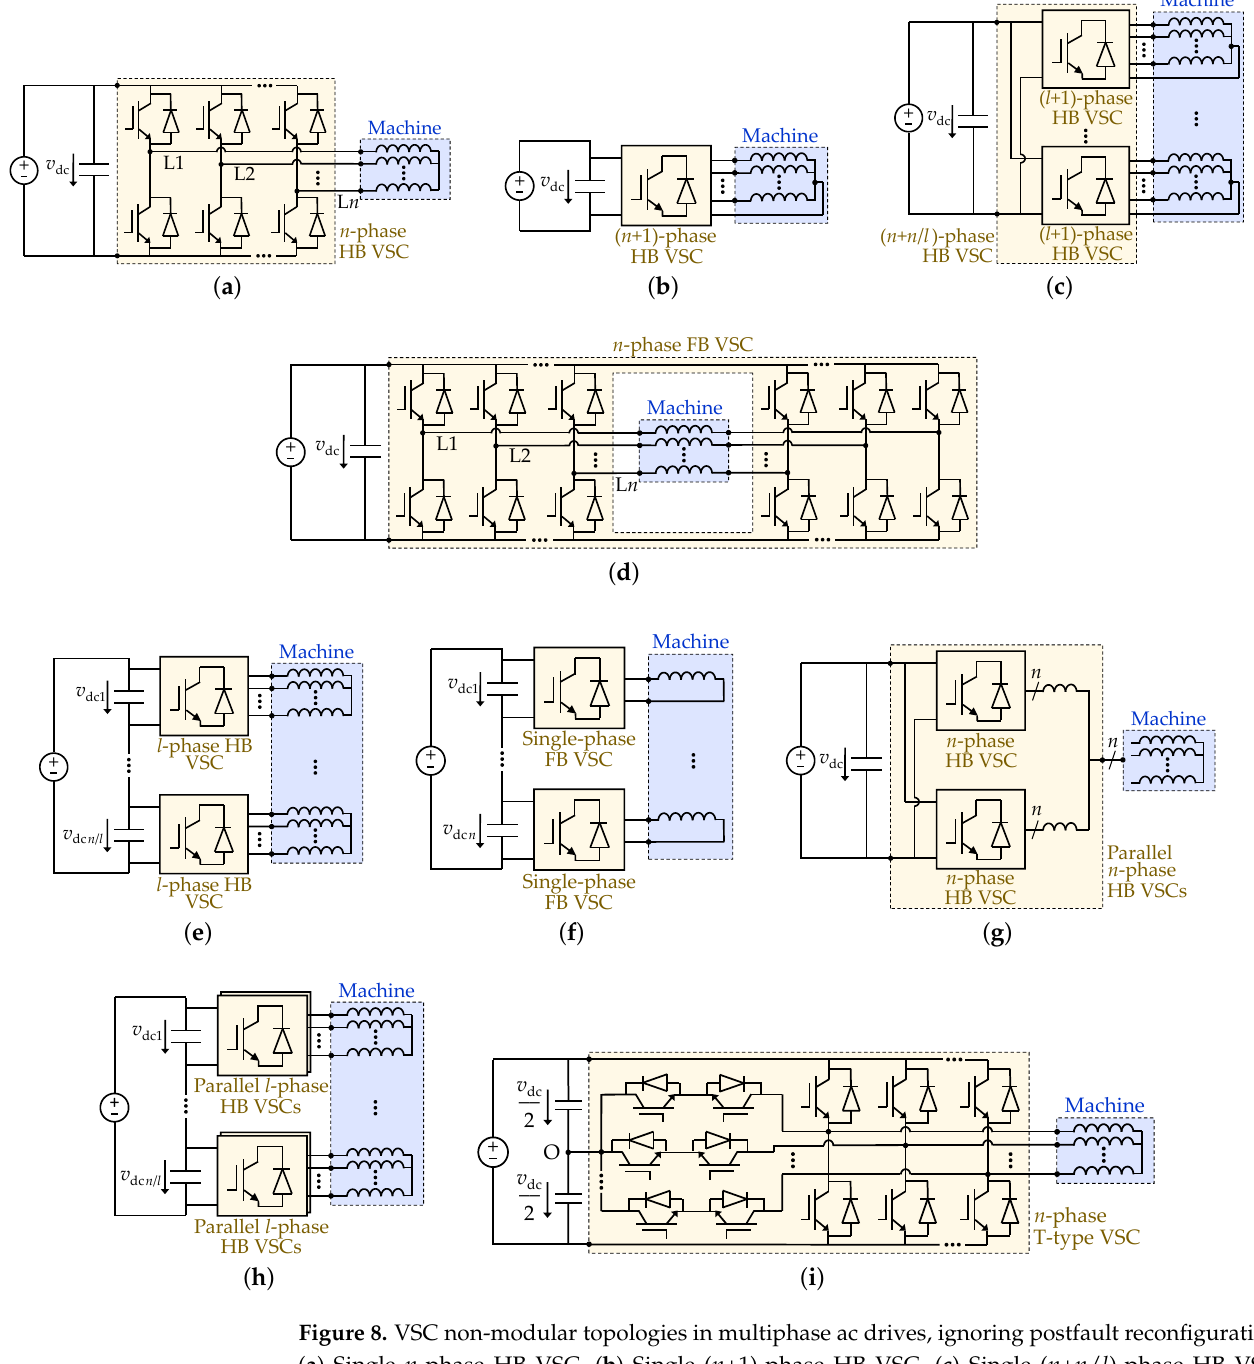
Figure 8. VSC non-modular topologies in multiphase ac drives, ignoring postfault reconfiguration. ( a ) Single n -phase HB VSC. ( b ) Single ( n +1)-phase HB VSC. ( c ) Single ( n + n / l )-phase HB VSC. ( d ) Single n -phase FB VSC for open-end windings. ( e ) Series dc-side connection of l -phase HB VSCs. ( f ) Series dc-side connection of single-phase FB VSCs. ( g ) Parallel n -phase HB VSCs. ( h ) Series dc-side connection of parallel l -phase HB VSCs. ( i ) Single n -phase T-type three-level